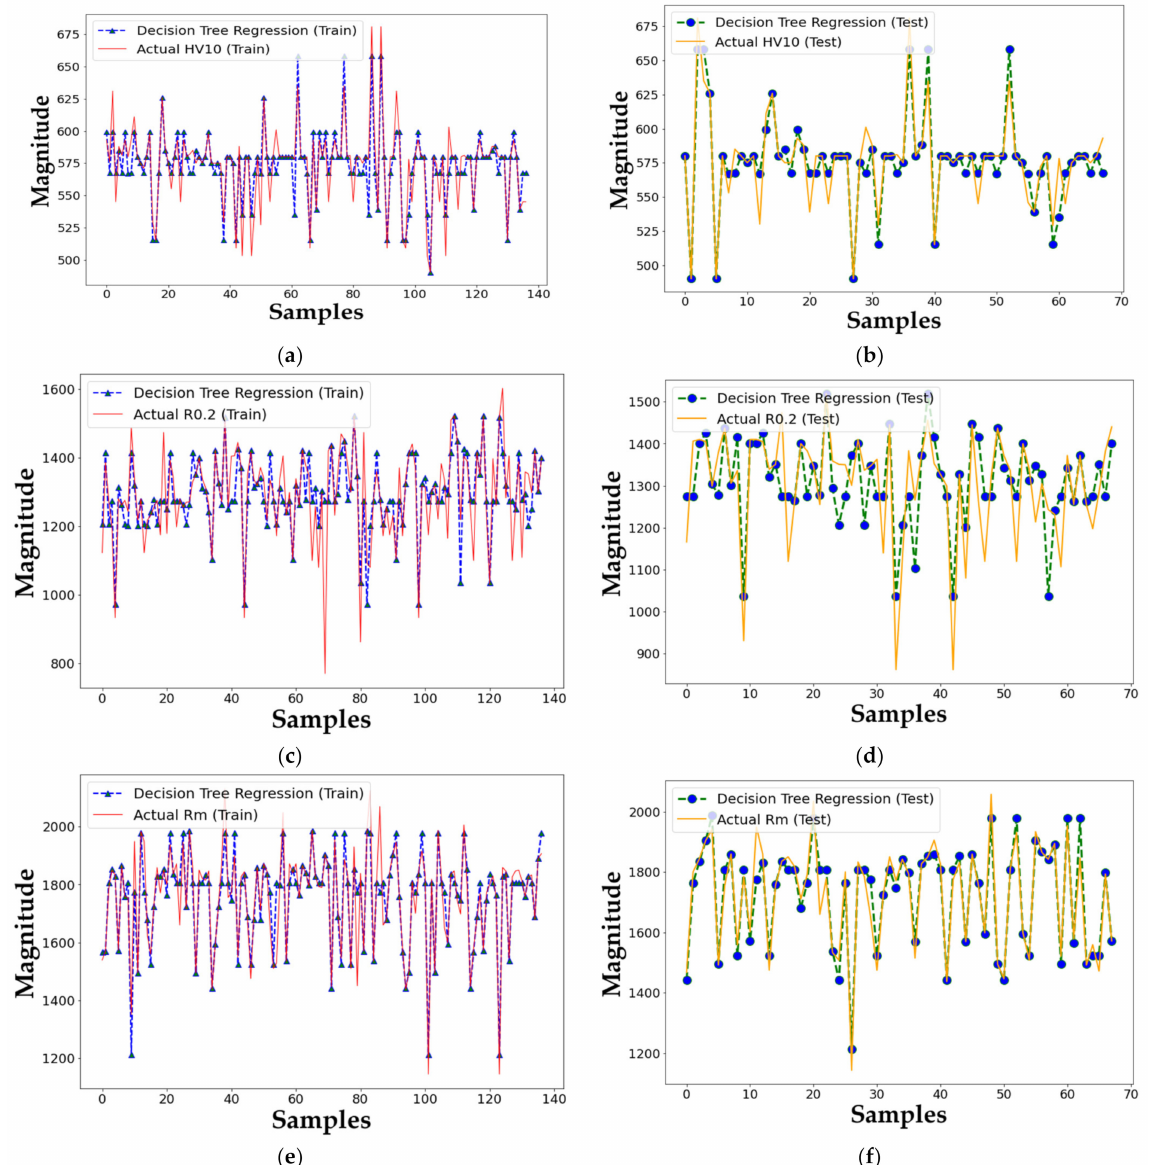
Figure 7. Evaluation of the Decision Tree Regression in modelling the digital twins of the alloy based on HV10 ( a , b ); R0.2 ( c , d ); Rm ( e , f ) in the presence of all inputs including heating, QT, PT, and Pt; ( a , c , e ): Train and ( b , d , f ):